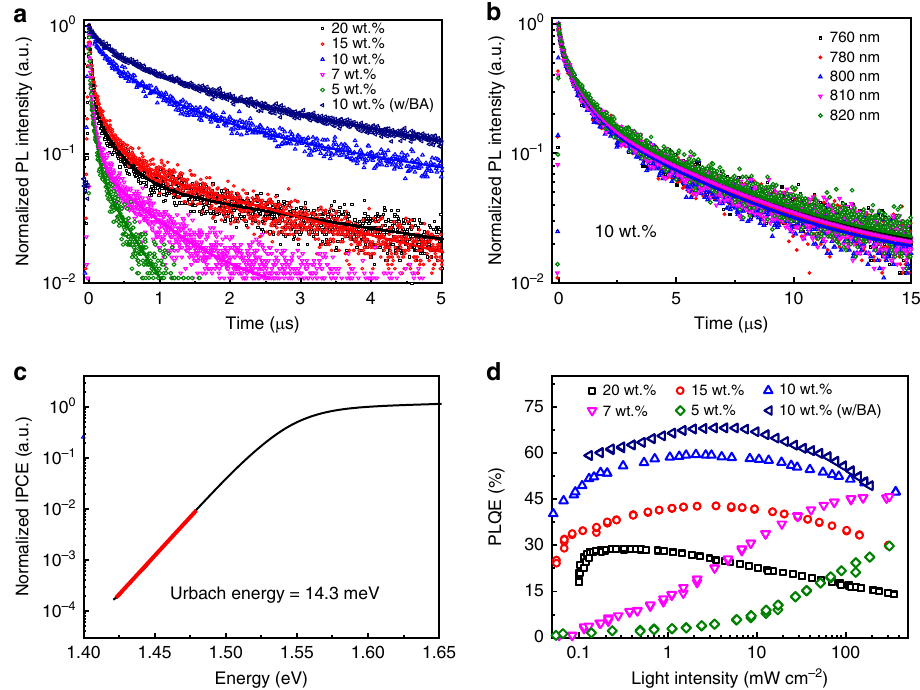
Fig. 4 Optical properties of perovskite fi lms. a Time-resolved PL for the FAPbI 3 fi lms fabricated with different concentrations of precursor solutions under a fl uence of 4 nJ cm − 2 . b Time-resolved PL of 10 wt.% FAPbI fi lm at various emission wavelengths, which are almost identical. c Normalized IPCE at the 3 absorption onset for a device fabricated with 10 wt.% FAPbI 3 fi lm, measured by using FTPS. An E u of 14.3 meV can be calculated, as indicated by the red line. d Excitation-intensity-dependent PLQE of FAPbI 3 fi lms fabricated from precursor solutions with different concentrations. The maximum PLQEs for 20 wt.%, 15 wt.%, 10 wt.%, 7 wt.%, 5 wt.% and BA treated 10 wt.% perovskite fi lms are 29, 42, 60, 46, 30, and 68%,